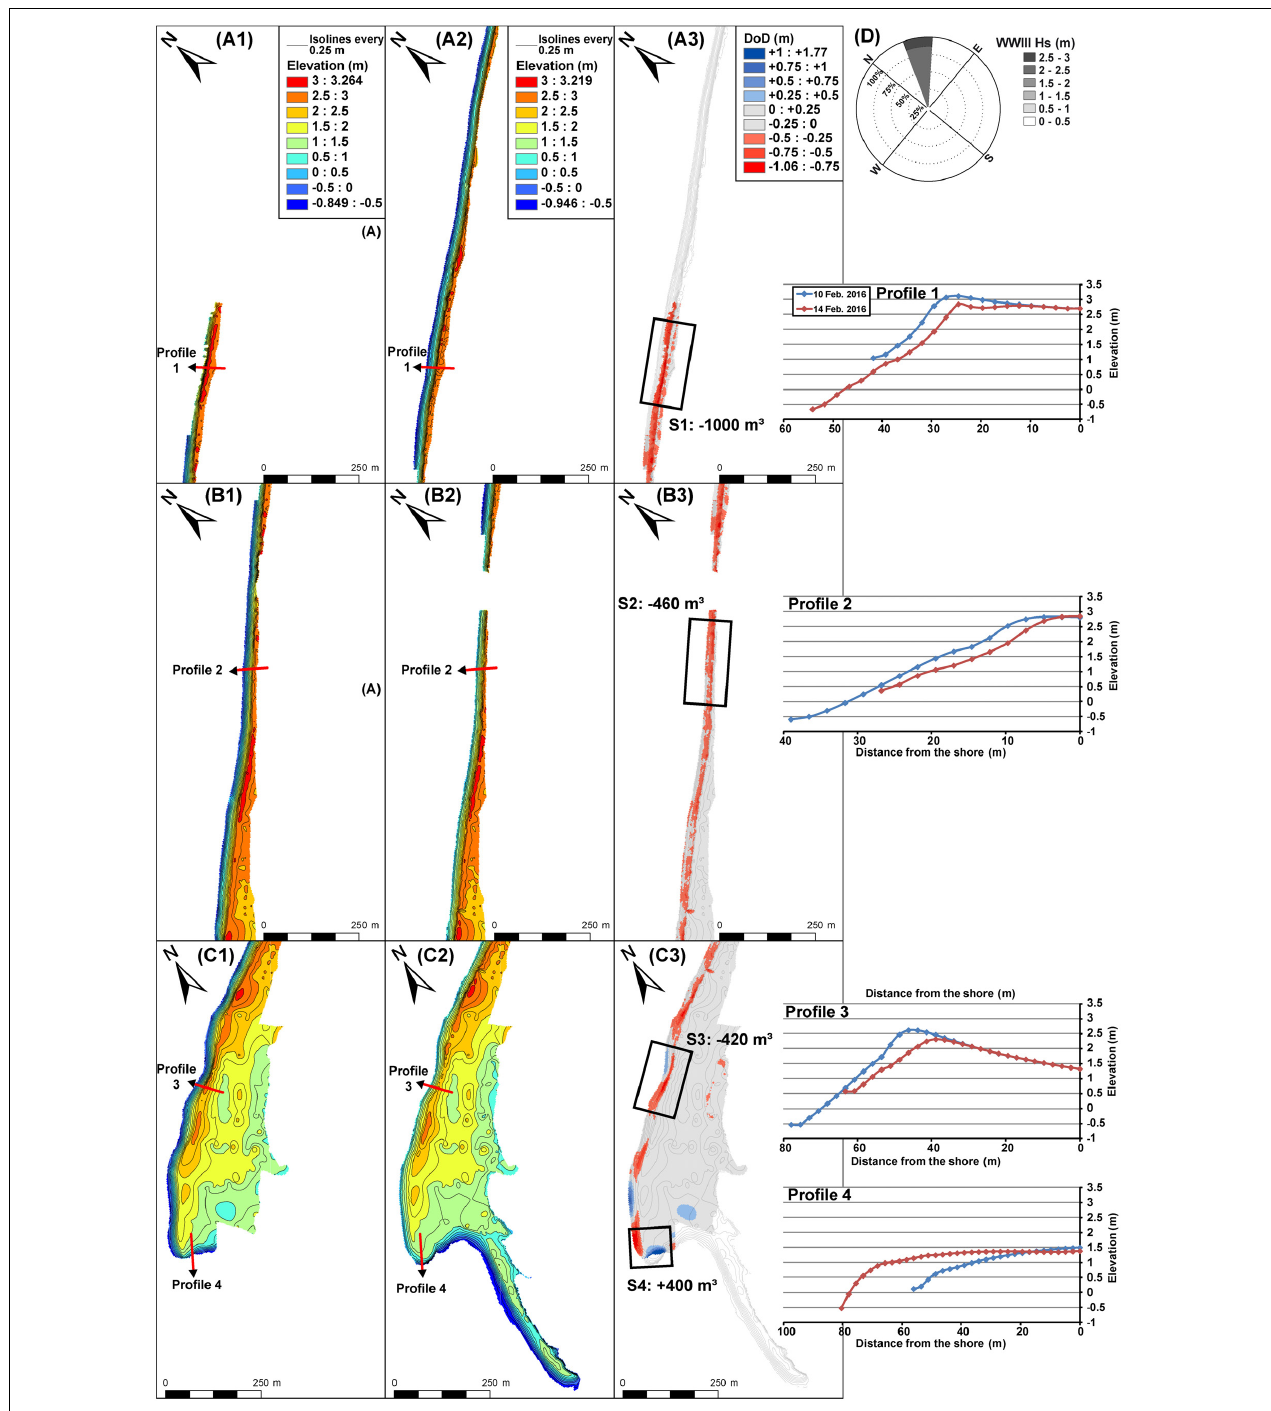
FIGURE 10 | High-resolution GPS-derived topography of Braamspunt beach depicted in three segments from the north to the south of the beach (A–C) , and beach sediment budget based on a beach base of –0.5 m relative to absolute datum. In the absence of local topographic benchmarks, elevation data were referenced to the world geoid EGM96 (Earth Gravitational Model) representing mean sea level. Each segment of beach comprised two digital elevation models (DEMs) (left: 10 February, center: 14 February), a DoD (right) that shows the differential between DEMs, and representative profiles. The DEMs, DoDs and profiles show a steep, narrow and eroding reflective beach in the north with a well-defined berm (profile 1), a wider but eroding and less steep beach (profile 2), a lower, retreating berm (profile 3), and a much lower (profile 4) ending steeply in the latest of the spit recurves of Braamspunt beach. The partial budgets highlight the contrast between a dominantly eroding beach along much of its length and a short spit recurve that serves as a sink for some of the sand eroded further updrift and transported by longshore currents.